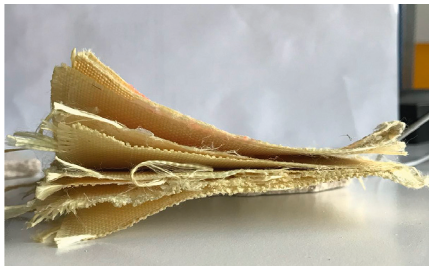
Figure 5: Geometry of 10 layers of Kevlar 29. Table 4: Material modeling of fiber-cement